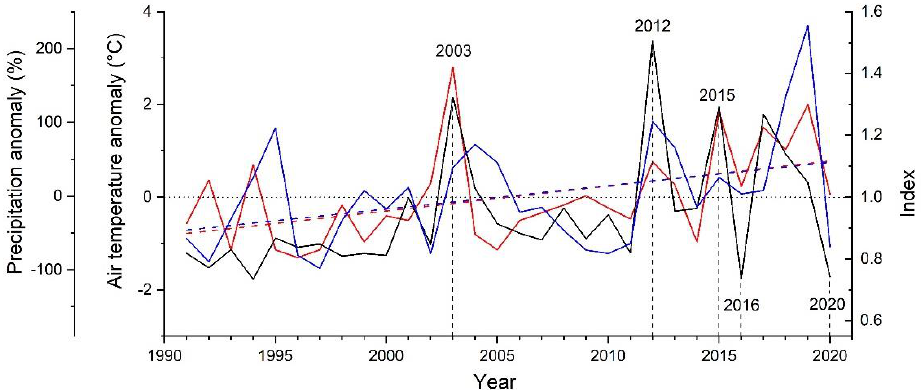
Figure 4. Comparison of standardized radial stem growth (black line) of Alnus alnobetula with anomalies in summer mean monthly air temperature (June–August; red line) and January precipitation (blue line) from long-term mean 1991 to 2020. Long-term means of air temperature during summer and January precipitation amounted to 8.3 ◦ C and 45 mm, respectively. Trend lines (linear regressions) for summer temperature ( R 2 = 0.212) and January precipitation ( R 2 = 0.138) are indicated by dashed lines. Extreme growth years are labelled and marked with vertical dashed lines.